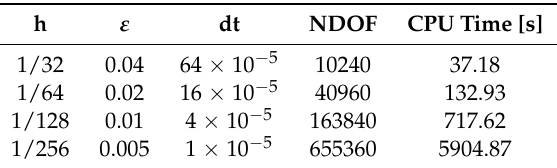
Table 1. Numerical parameters: grid resolution h , diffuse interface width ε , and time step size dt and the resulting total degrees of freedom NDOF per time step and average CPU time of each parameter